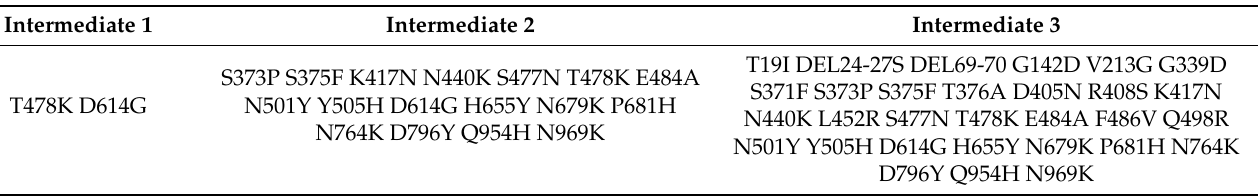
Table 1. List of mutations that are supposed to be present in the three missing intermediates related 187 to the omicron lineage of evolution.